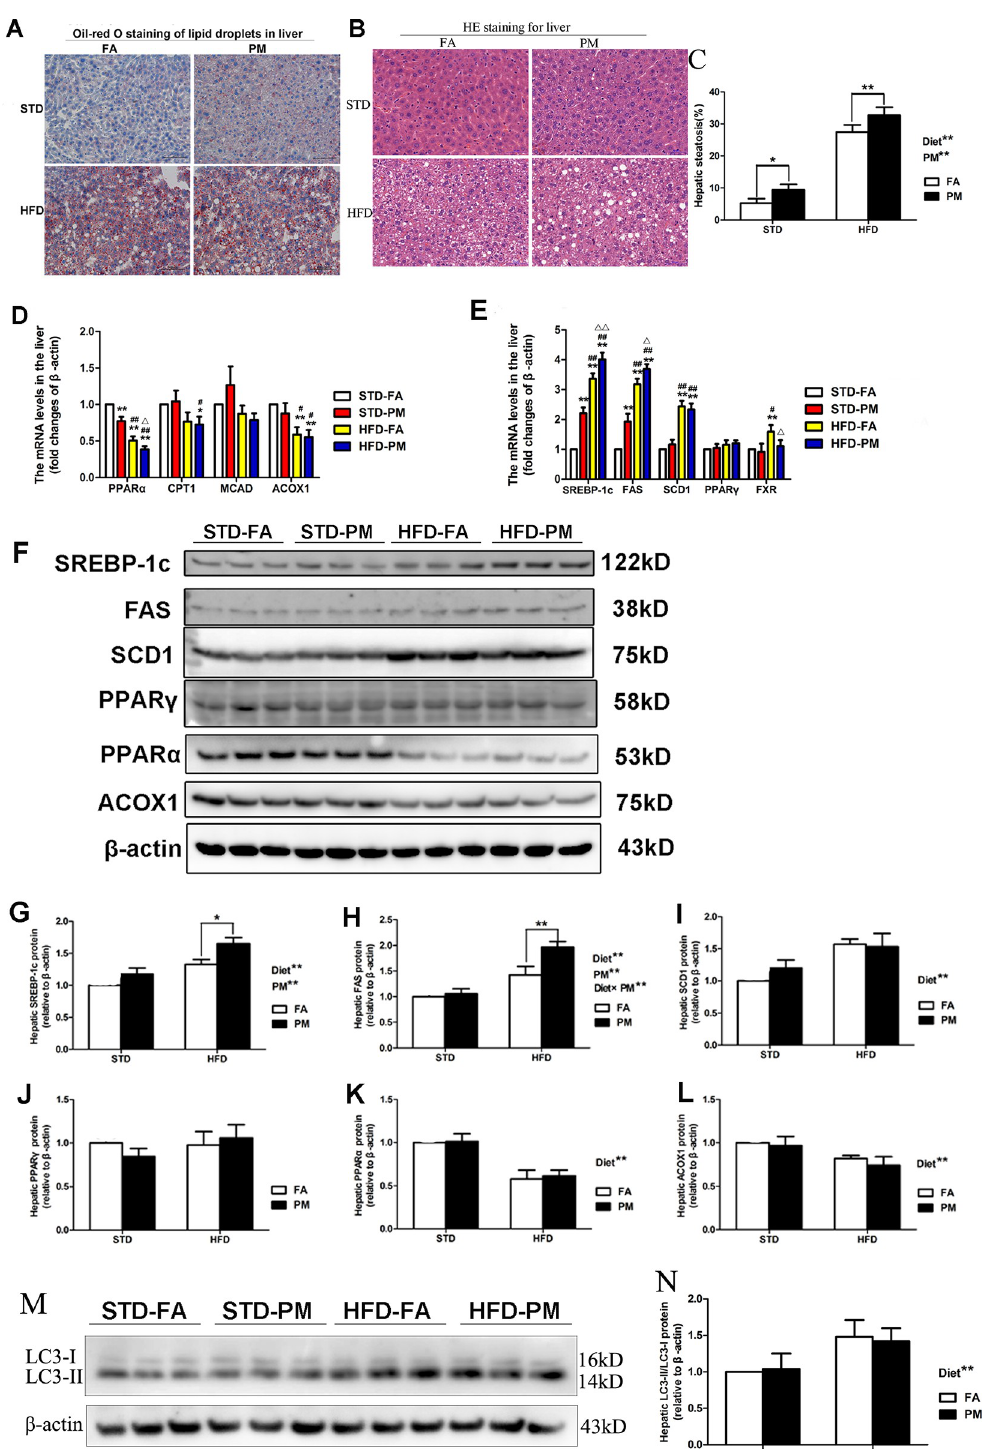
Fig 3. Ambient PM exposure leads to hepatic steatosis by impairing hepatic lipid metabolism. (A) Oil Red O staining observation of liver ( × 200, scale bars = 100 μ m). (B) H&E staining observation of liver ( × 200, scale bars = 50 μ m). (C) The volume density of quantitation of hepatic steatosis (n = 5). (D) The genes expression involved in fatty acid β -oxidation in liver (n = 5). (E) The mRNA expression of genes involved in lipogenesis and FXR in liver (n = 5). (F) Bands of PPAR α , PPAR γ , ACOX1, FAS, SREBP-1c, SCD1. (G) Protein expression of SREBP-1c (n = 3). (H) Protein expression of FAS